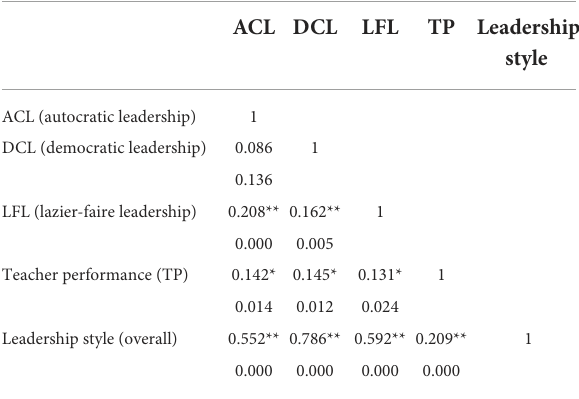
TABLE 3 Relationship with Principals’ leadership style and teachers’